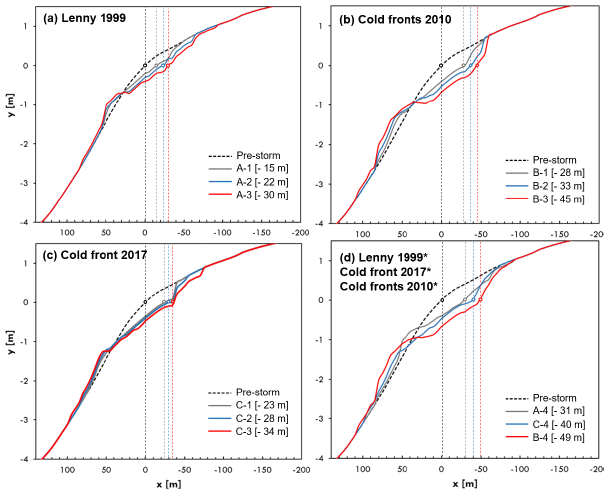
Figure 7. Post-storm retreats with different SLR scenarios of Boca- grande’s control profile for (a) Lenny 1999 (cases A-1, A-2, and A-3), (b) the cold fronts of 2010 (cases B-1, B-2, and B-3), (c) the cold front of 2017 (cases C-1, C-2, and C-3), and (d) the mentioned storms including high tide conditions ( + 0 . 25m) (cases A-4, B-4, and